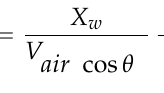
Table 1. The risk level of PD according to the PowerPD reference.